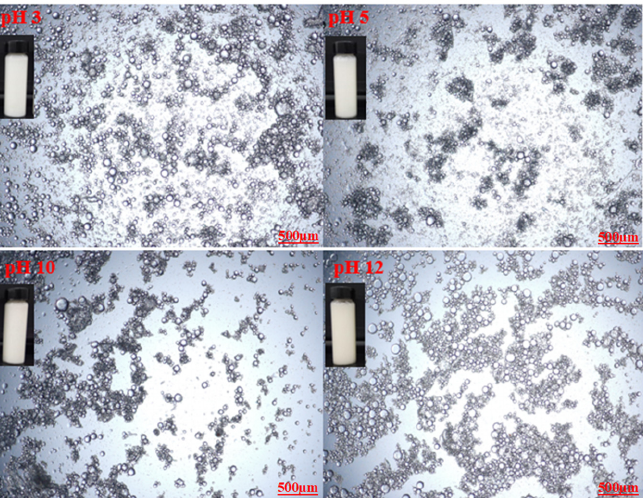
Figure 5. Optical microscopy images of 1%-CT/1%-AG emulsion under different pH levels.